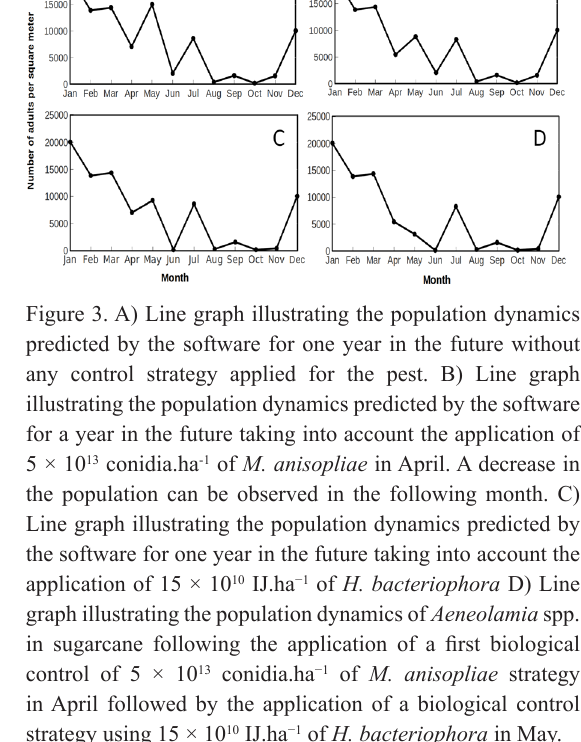
Table 1. Monthly average temperatures and relative humidity in the coastal zone of El Salvador .